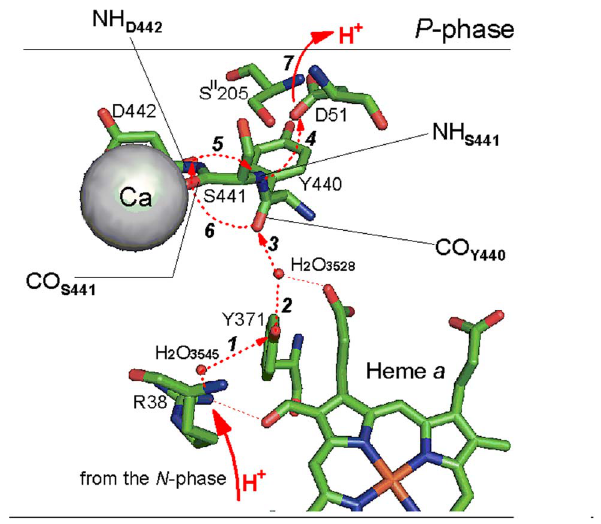
Figure 8. Interaction of Ca 2 + with the exit of proton channel H in bovine heart oxidase. Structure of the exit part of the H-channel is shown based on the oxidized COX crystal structure, PDB entry 1V54. All the groups shown belong to subunit I (polypeptide A) except for S II 205 from subunit II (polypeptide B). The scheme gives a scenario of proton transfer combined from refs. [44,45,49]. Proton trajectory is depicted by red arrows and sequence of the proton transfer steps is indicated by numbers. Oxidation of heme a by the binuclear site brings about a conformational change that unlocks the H-channel below the heme [46] (cf. [50] for an alternative proposal) and pumped proton arrives to the guanidine group of R38 from the N -aqueous phase (step 1 ) via the input part of the H-channel (cf. Figure 1A ); it travels further via the R38-bound H 2 O 3545 (that has then to shift closer to Y371), OH group of Y371 and H 2 O 3528 to finally protonate the backbone carbonyl group of Y440 (steps 2 – 4 ). The carbonyl function C=O Y440 protonated, makes the -NH S441 acidic (imidic acid) and allows for its facile